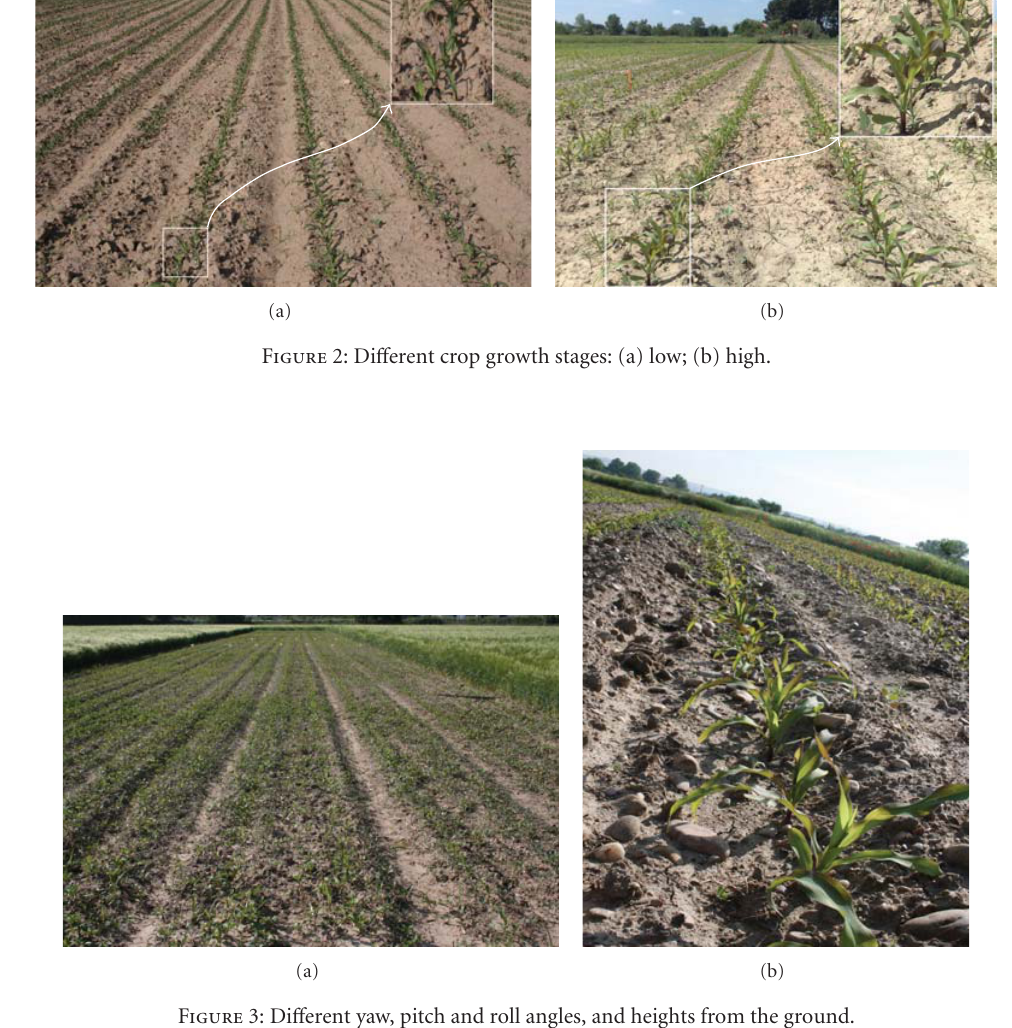
Figure 3: Di ff erent yaw, pitch and roll angles, and heights from the